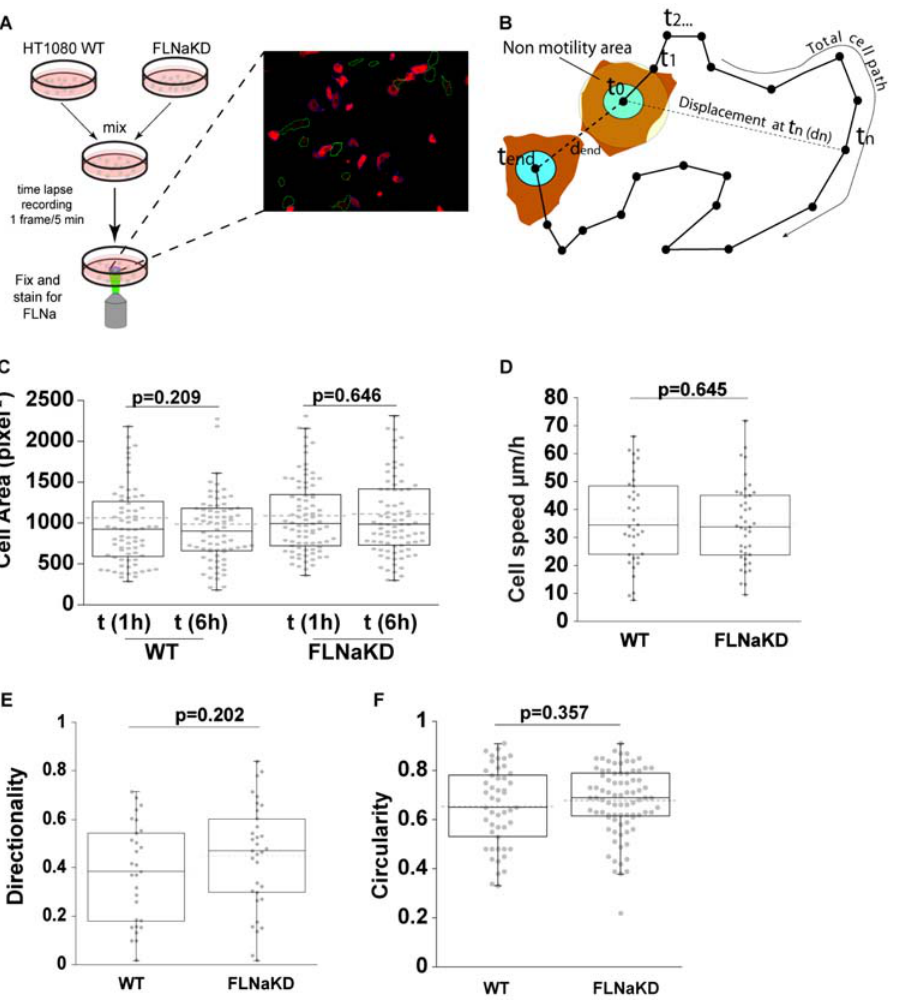
Figure 2. FLNaKD cells in random cell migration assay. A ) Flow chart of the time-lapse experiments. Cells were suspended, washed, and control and knockdown cells mixed before seeding onto FN-coated plates. 10 minutes after plating unattached cells were washed away and imaging was initiated 1 hour after plating. At the end of the time-lapse recording, cells were fixed and stained for FLNa expression. WT cells are outlined in white, FLNaKD cells in green. B ) Schematic diagram of migration parameters. Cell is considered migratory if max d . 25 (average cell radius); final speed=Total cell path/t end ; directionality =d end /Total cell path. C ) Comparison of cell area at the start and at the end of time-lapse recording. 1 square pixel 2 =1.664 m m 2 . Dots plot shows the overall population distribution (sample size: WT=74; FLNaKD=82; from 5 independent experiments), dotted line shows the mean, box and whiskers plots show quartiles. P values were calculated using a paired t-test. D ) Speed of HT1080 WT and FLNaKD (sample size WT=38; FLNaKD=41; from 4 independent experiments). E) Directionality (defined as d end /total cell path) comparison between HT1080 WT and FLNaKD (sample size: WT=29; FLNa=33; from 3 independent experiments). F) Circularity (as defined in ImageJ=4 p (area/perimeter 2 ) comparisons between HT1080 WT and FLNaKD cells 6 hours after plating (sample size: WT=49; FLNaKD=83; from 4 independent